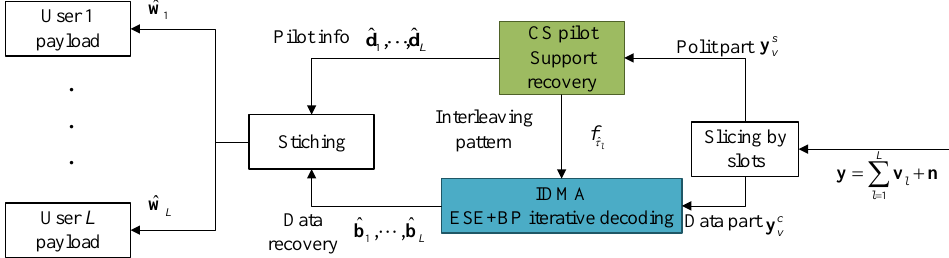
Figure 3. Intra-slot decoder structure at slot v